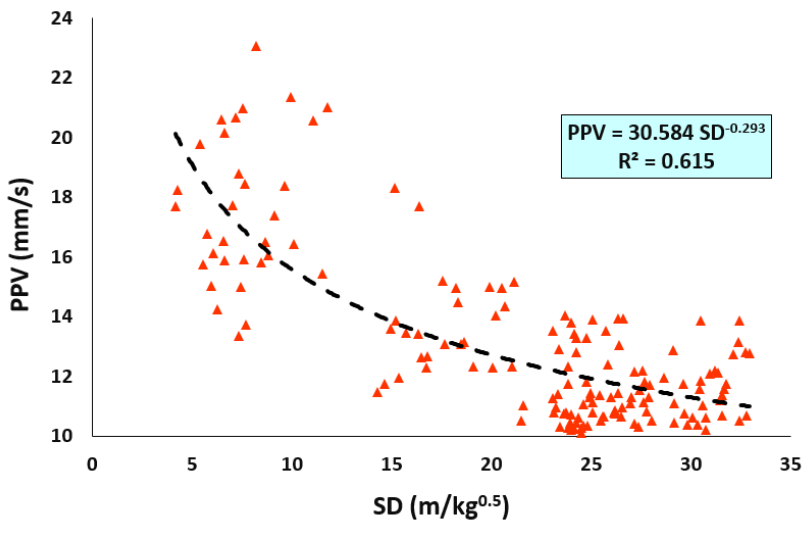
Figure 5. PPV values as a function of scaled distance based on 154 data samples.